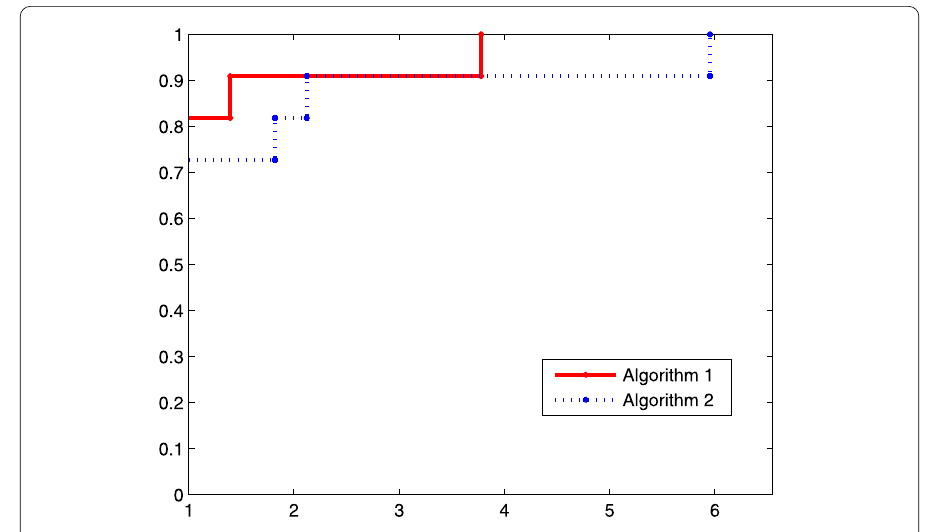
Figure 5 Performance profiles of the CPU time of two algorithms ( n = 1,000).